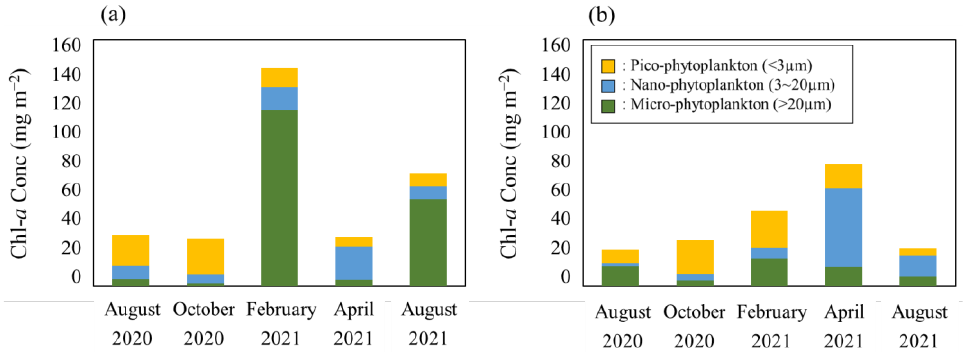
Figure 4. Seasonal variations in different size fractioned chlorophyll- a concentrations at 105-05 ( a ) and 105-11 ( b ) sites.